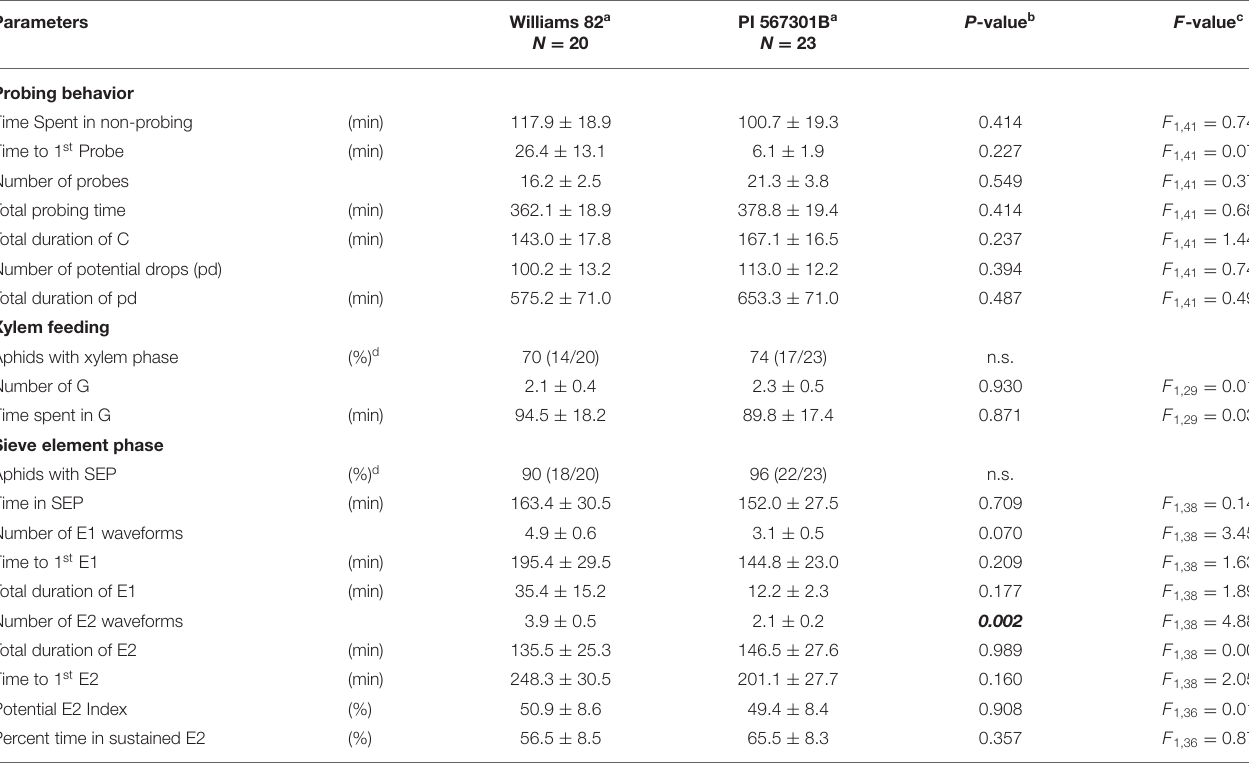
TABLE 3 | Feeding behaviors of aphids on detached leaves plants of Williams 82 and PI 567301B.